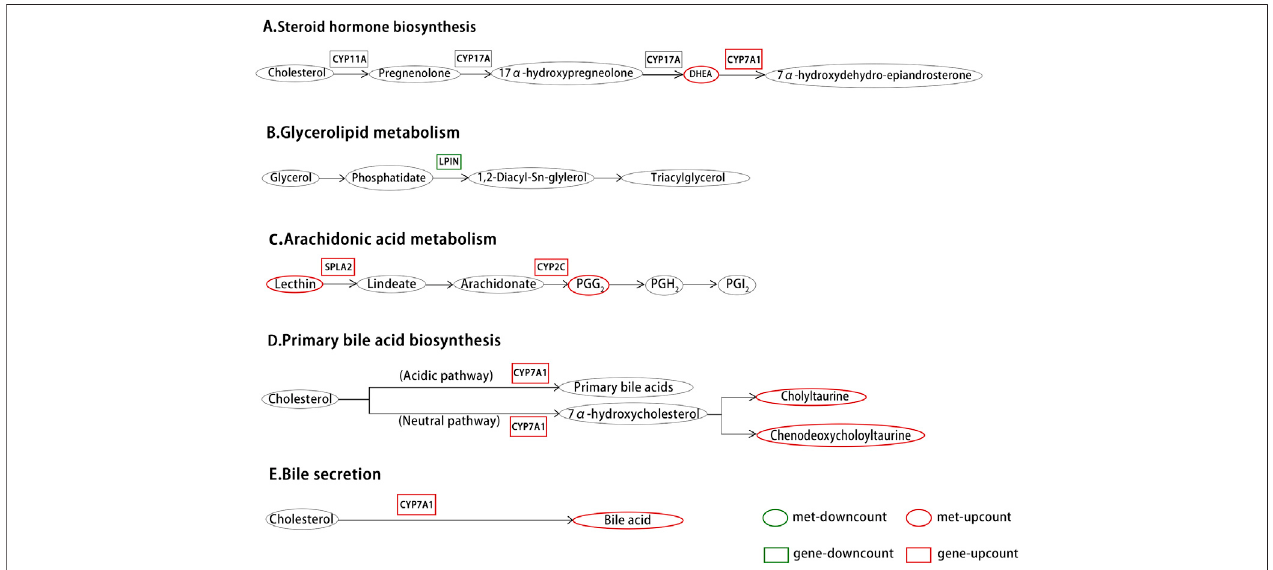
FIGURE 6 | Differential metabolites and differential gene expression statistics histogram (n (cid:2) 3).